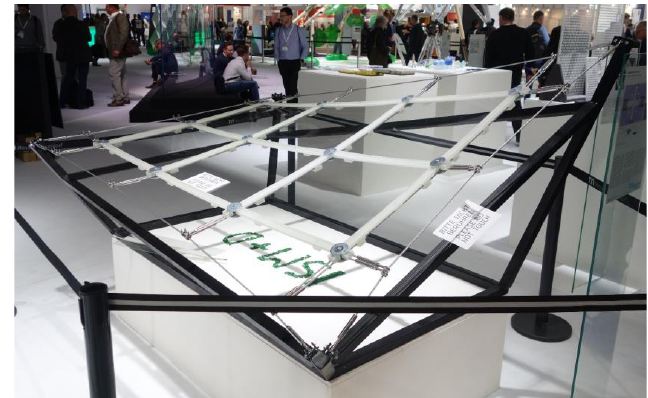
Fig. 9 Thin glass cable net structure at Glasstec 2018 (Peters et al.